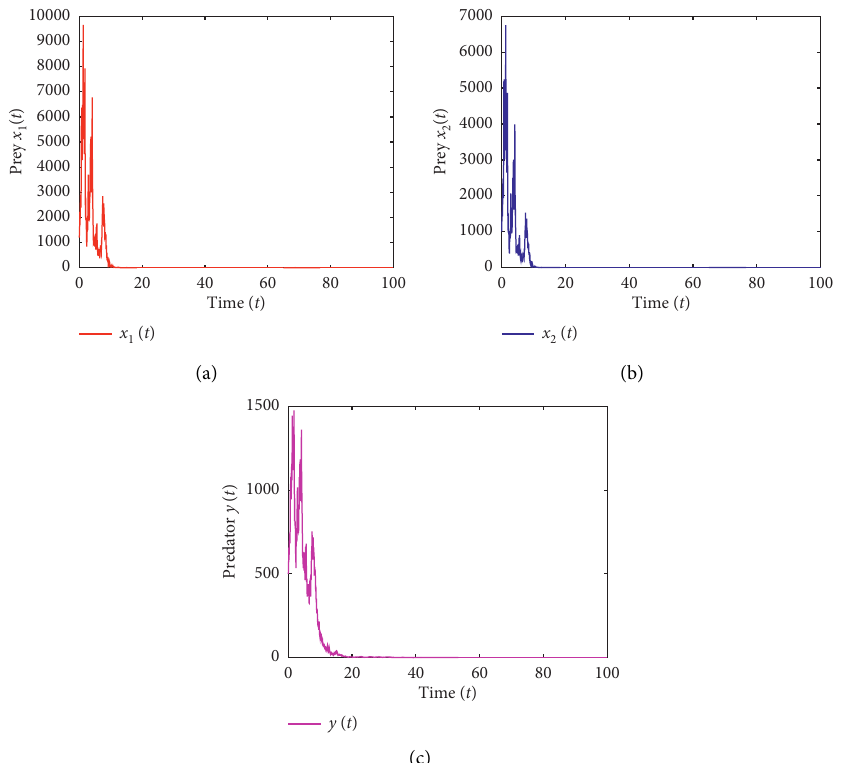
Figure 5: The trajectories of stochastic model (5) with σ 2 (c) predator y ( t )